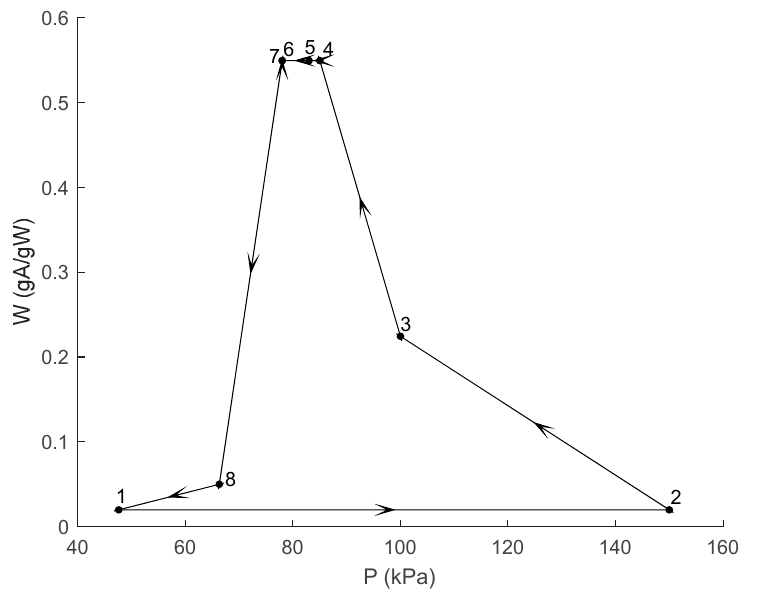
Figure 3. W-P diagram for the baseline cycle.